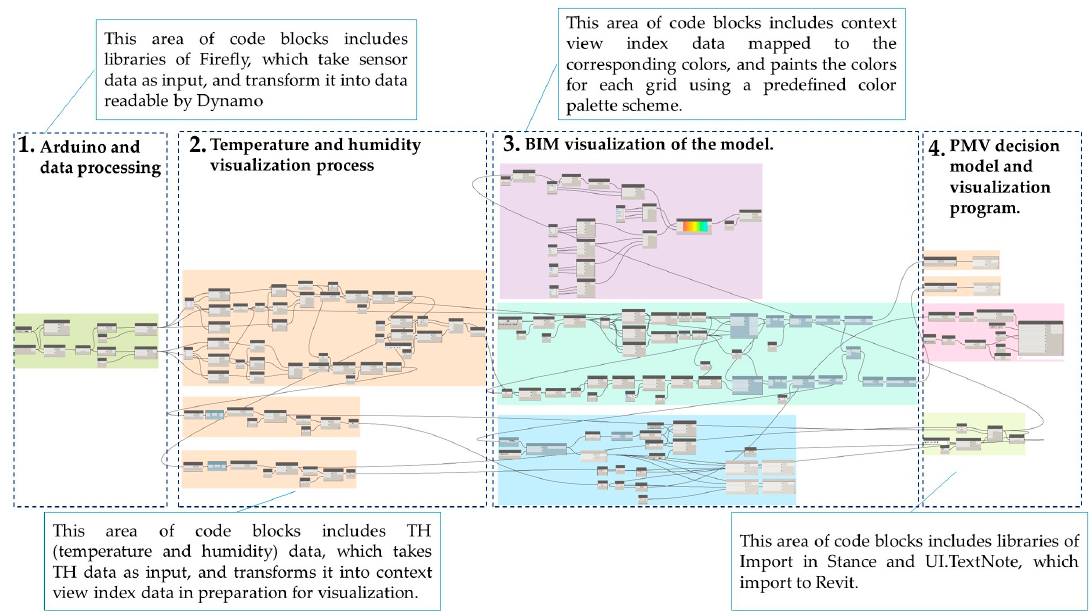
Figure 2. Data visualization process (Dynamo build method and structure).